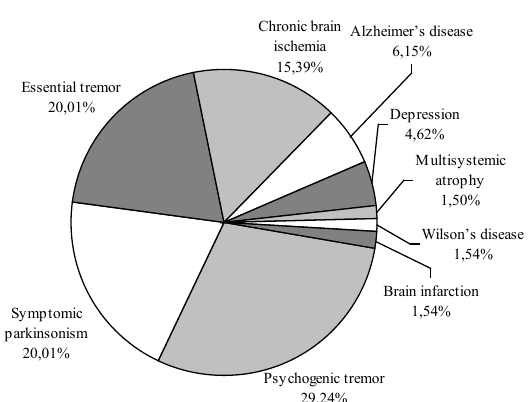
Figure 2. Distribution of PD clinical forms in men ( ) and in women ( ).